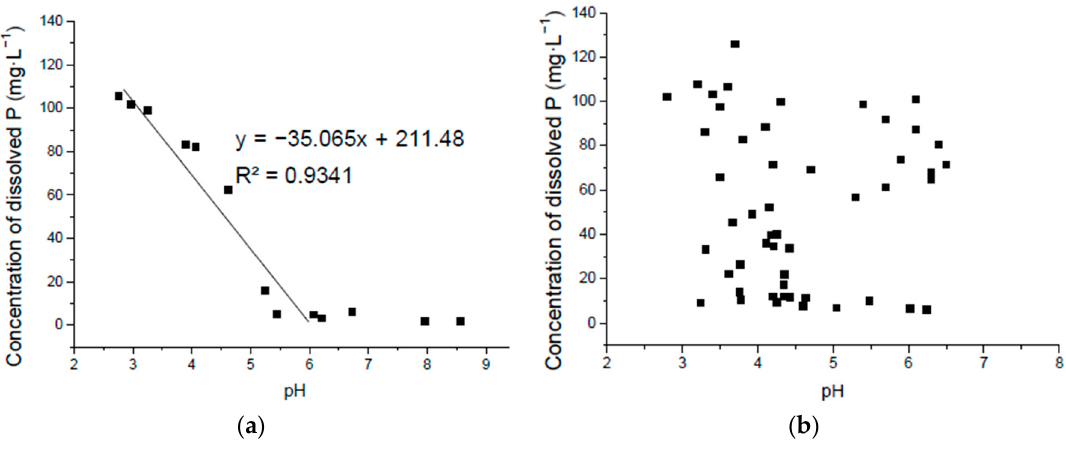
Figure 5. Correlation of solubilized P and pH in Ca 3 (PO 4 ) 2 liquid medium without seeding the isolates where the pH was adjusted by hydrochloric acid ( a ) and seeding with the isolated bacteria ( b ).